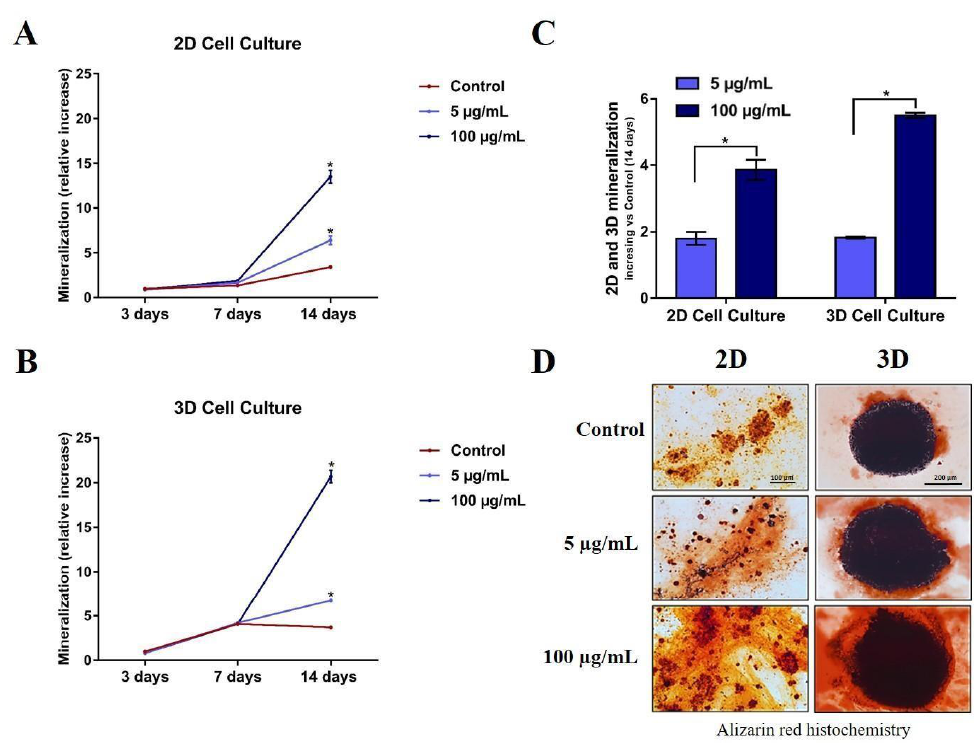
Figure 6. Mineralized matrix produced by human osteoblasts (SAOS-2) in 2D and 3D cells exposed to TiO 2 NPs (0, 5 and 100 μg/ mL) during 3 and 14 days in osteogenic medium. Alizarin red assay shows a dose-dependent matrix production in ( A ) 2D SAOS-2 model and ( B ) 3D SAOS-2 models. The graphics in ( C ) present a comparison between the inorganic matrix production on both 2D and 3D models at 14 days (final experimental time) normalized vs each control to show dose-dependent mineralization fold increase in the different models. The results are average ± standard deviation of three independent experiments * p < 0.05; ( D ) representative images obtained through optical mi- croscopy.